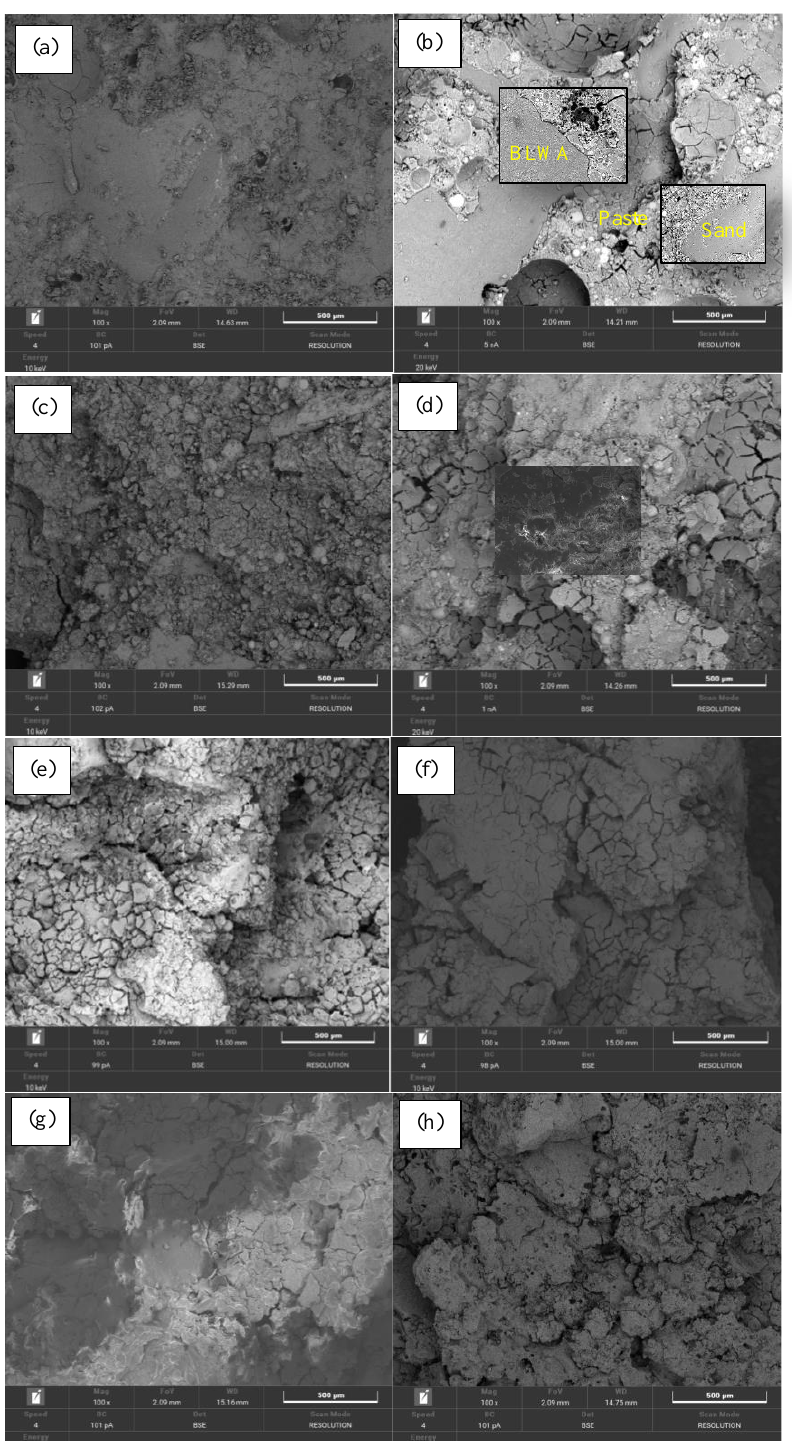
Figure 20. Microstructure of mortars: ( a ) LG00-25 °C, ( b ) LG10-25 °C, ( c ) LG00-300 °C, ( d ) LG10-300 °C, ( e ) LG00-600 °C, ( f ) LG10-600 °C, ( g ) LG00-900 °C, and ( h ) LG10-900 °C.